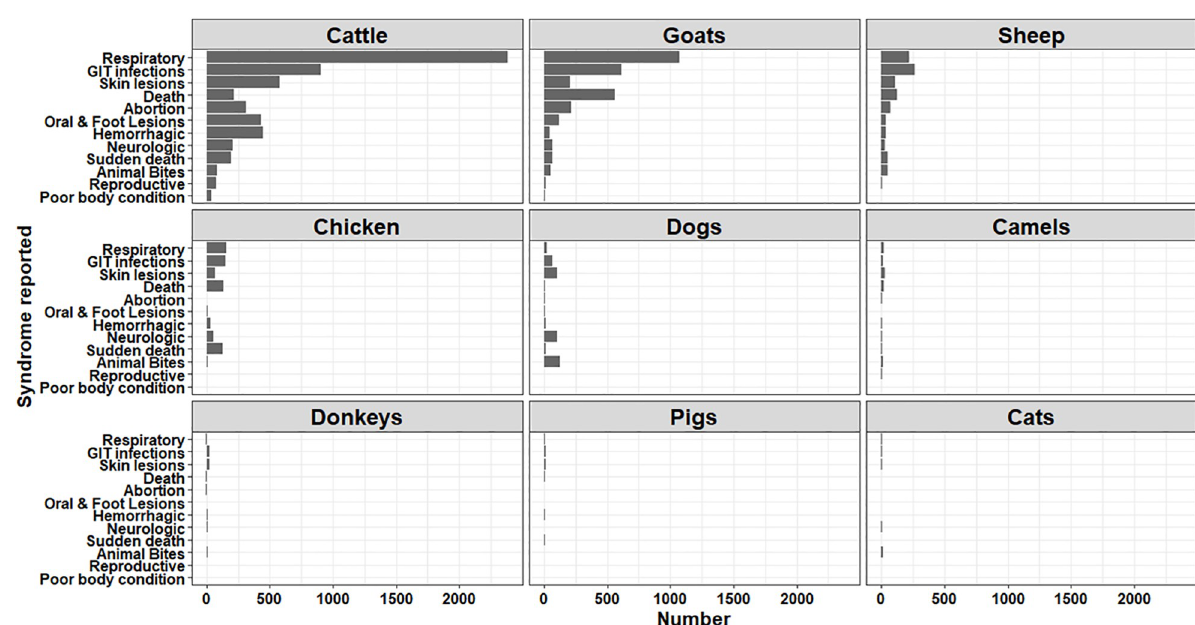
Fig 4. Trends in disease syndromes reported in domestic animals in Kenya using the KABS mobile phone application, (2017–2019).